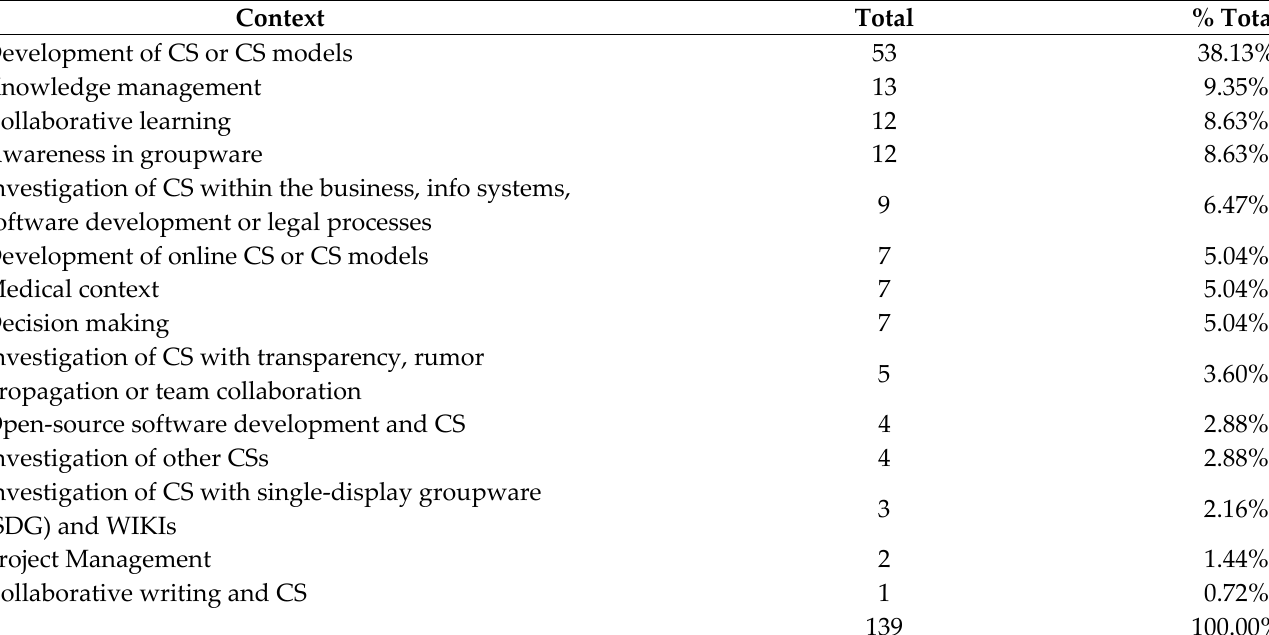
Table 2. Frequency of context of use